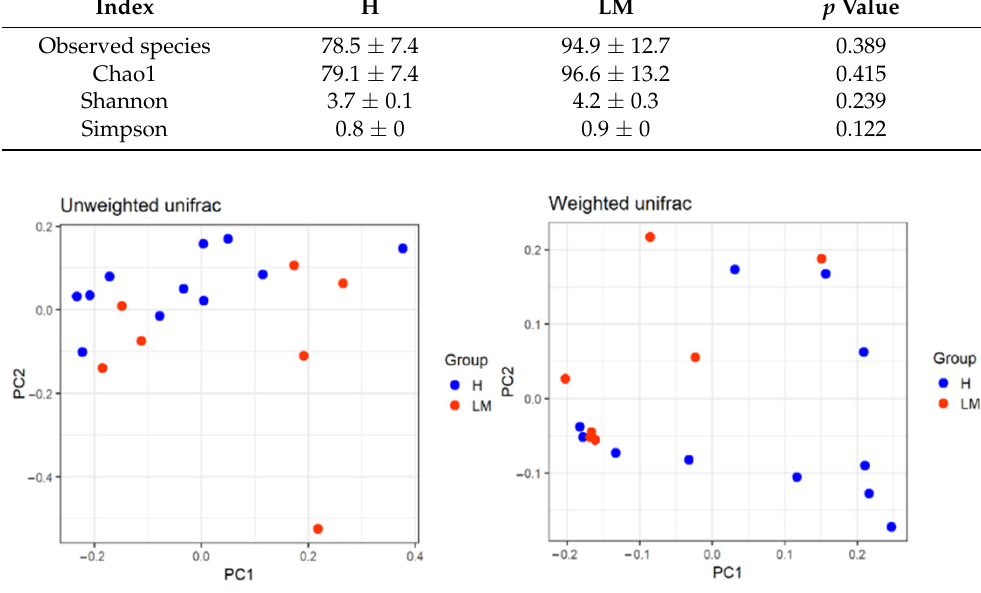
Figure 1. Beta diversity using weighted and unweighted UniFrac distances between healthy (H) and lymphoma (LM) groups.